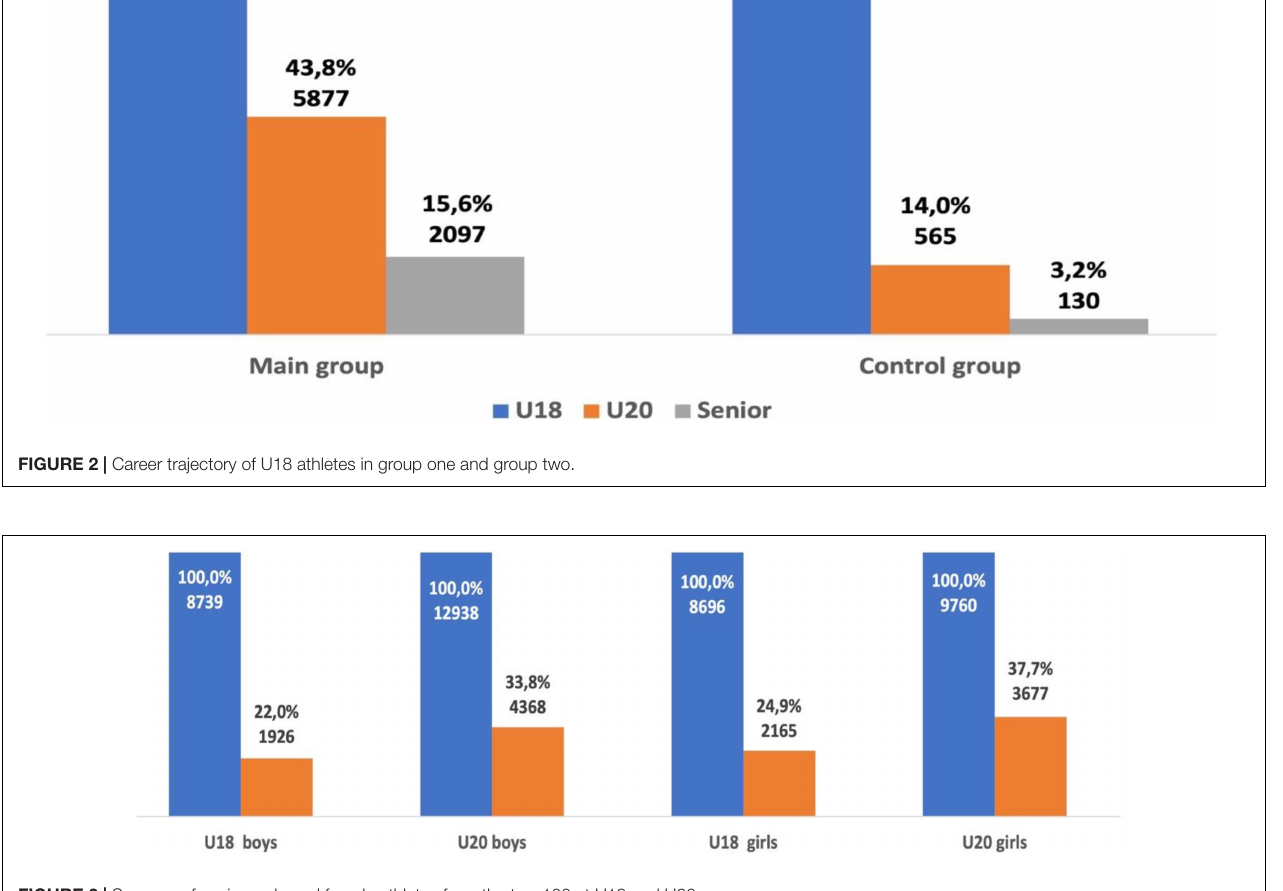
FIGURE 3 | Success of senior male and female athletes from the top-100 at U18 and U20.